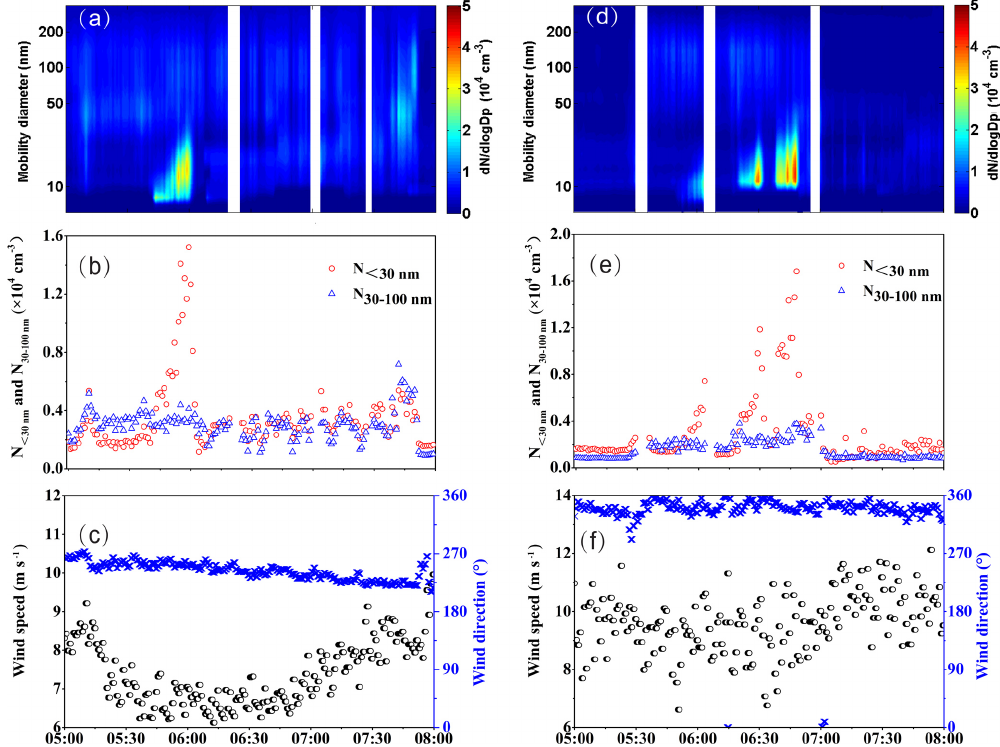
Figure 5. Temporal variations of particle number size concentrations, particle concentrations, and meteorological parameters for NPF events observed on DOY 98 (a, b, c) and DOY 103 (d, e, f) 2014. Data points suffering from ship self-emissions were removed to avoid